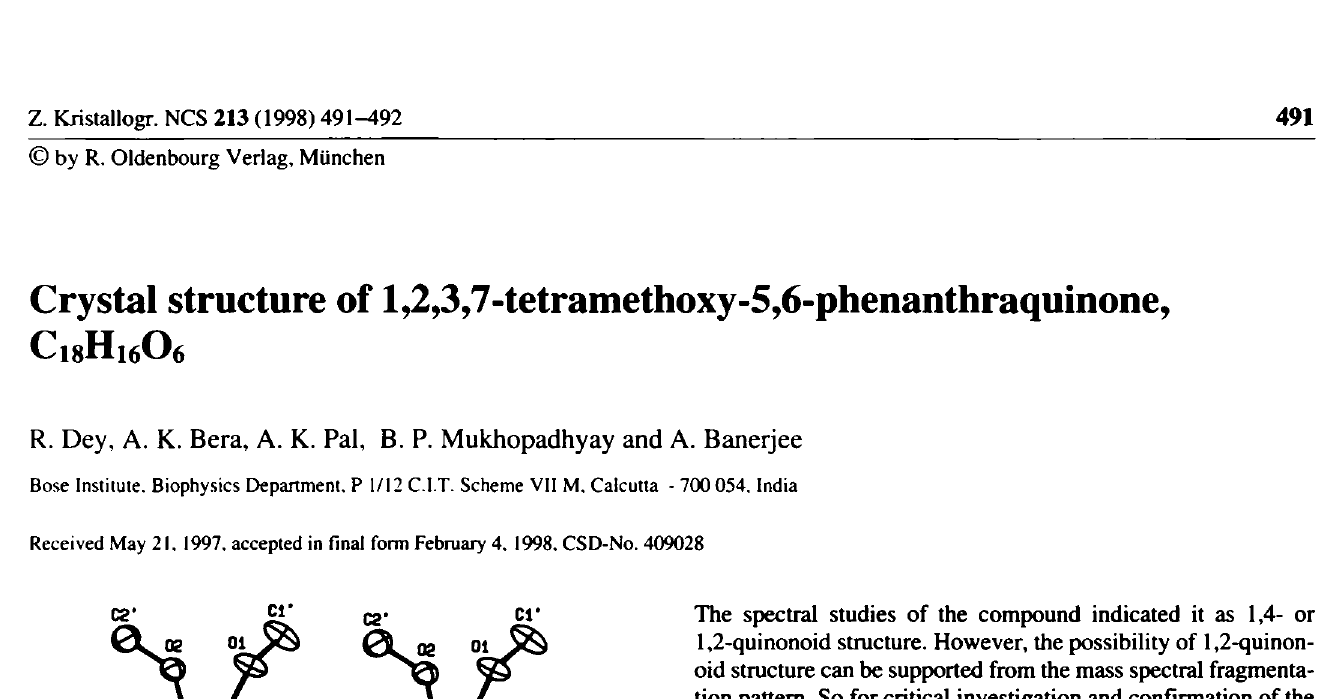
Table 1. Parameters used for the X-iay data collection